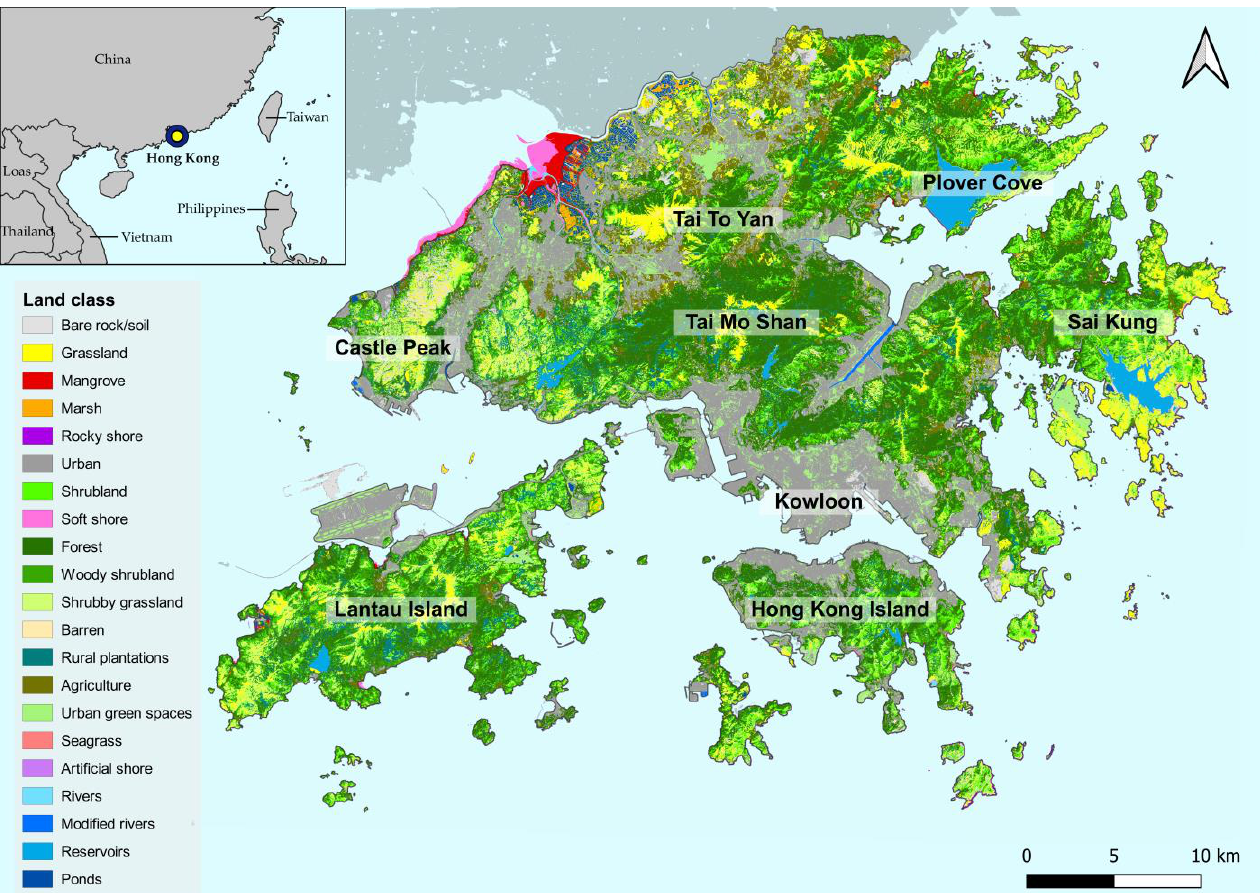
Figure 1. Map showing the study area of Hong Kong. The top left panel indicates the geographical position of Hong Kong overlayed on country boundaries from Natural Earth . The land classification raster is derived from Kwong et al. (2022) [58].